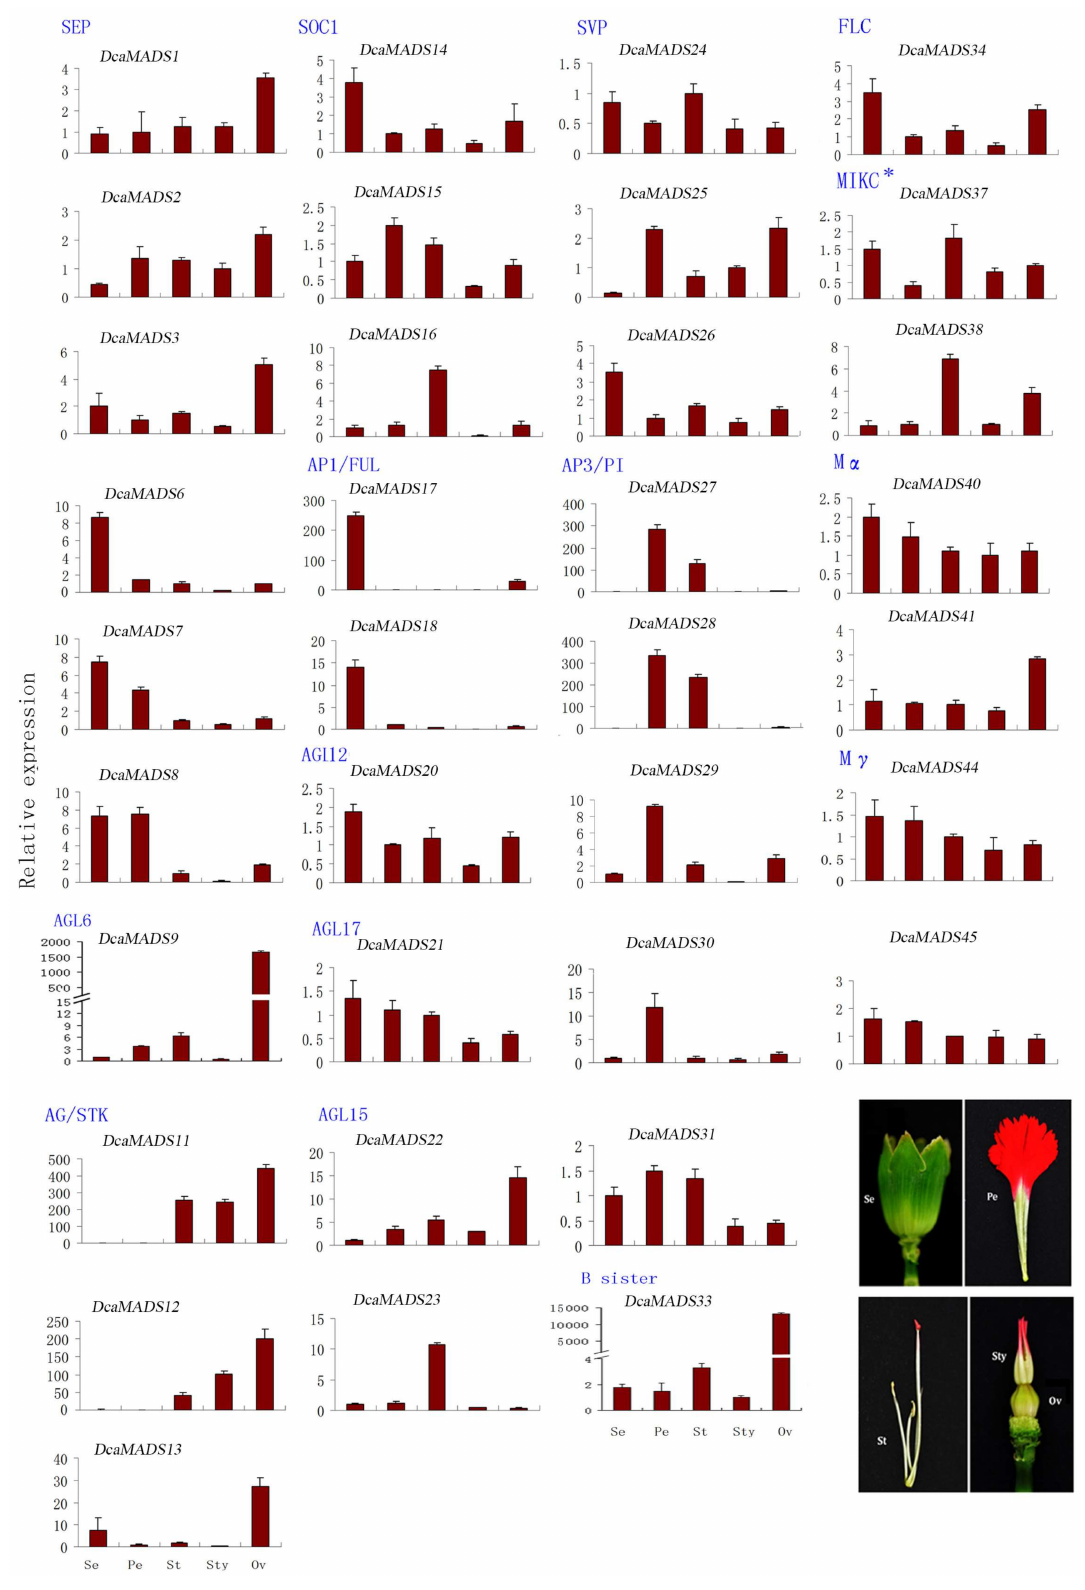
Figure 6. Organ specific expression analysis of 35 DcaMADS genes at different flower whorls. Se: sepals, Pe: petals, St: stamens, Sty: styles, Ov: ovaries. Each bar shows the standard deviation of triplicate